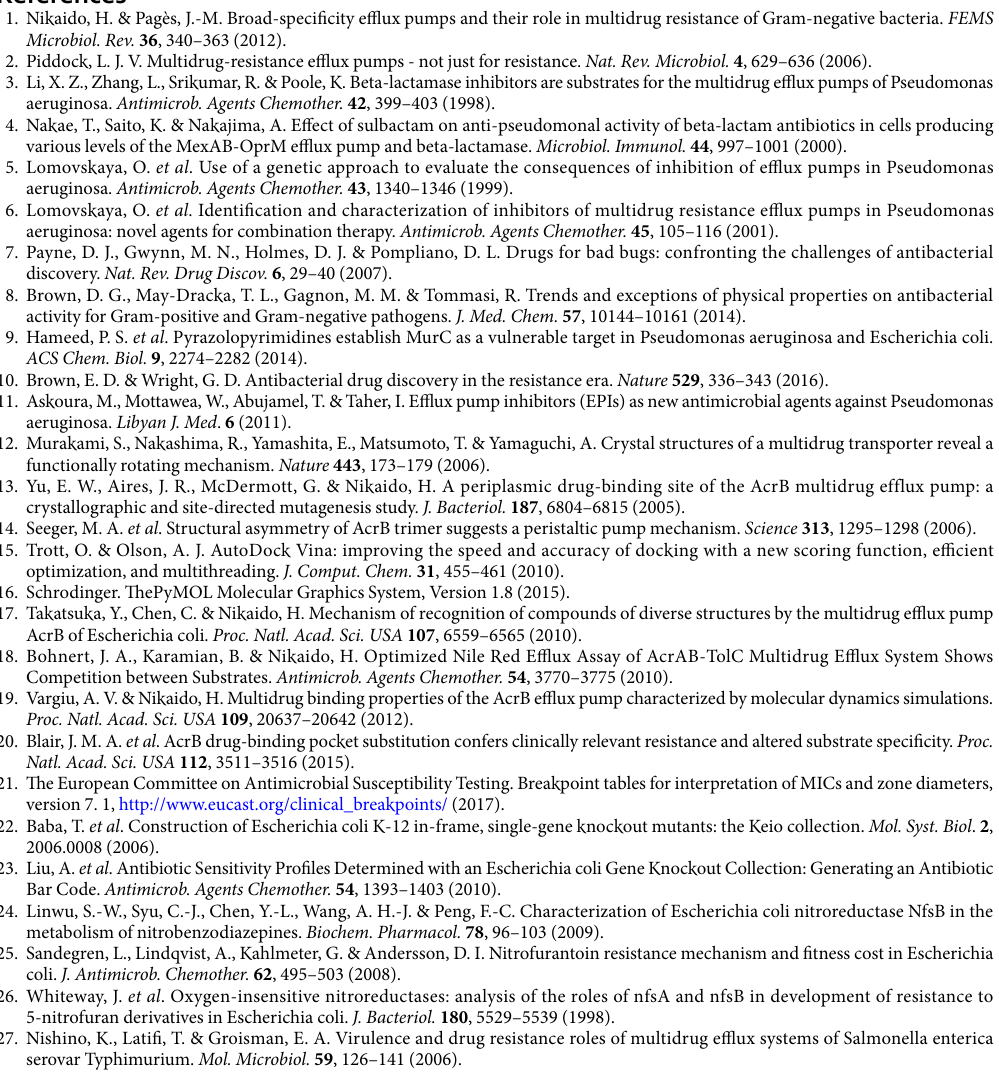
Compound 24: N-(4-(3, 5-difluorophenyl)thiazol-2-yl)-5-nitrothiophene-2-carboxamide (CAS: 2147485-29-6). Compound 24 was synthesized using scheme and procedure analogous to compound 7 from commercially available 4-(3,5-difluoro-phenyl)-thiazol-2-ylamine ( CAS: 676348-23-5 , Fluorochem) and 5-Nitro-2-thiophencarboxylic acid. 1H NMR (400 MHz, DMSO-d6) δ = 13.39 (bs, 1H), 8.25-8.23 (m, 2H,), 8.01 (s, 1H), 7.67-7.65 (m, 1H), 7.23-7.21 (m, 1H). LCMS: Calculated for C 14 H 7 F 2 N 3 O 3 S 2 , = 367.34, Observed = 368.0, HPLC = 99.05% (HPLC Column: Phenomenex Gemini-NX C18 (150 × 4.6 mm) 5micron, Mobile Phase A: 10 mM Ammonium acetate in water, Mobile Phase B: